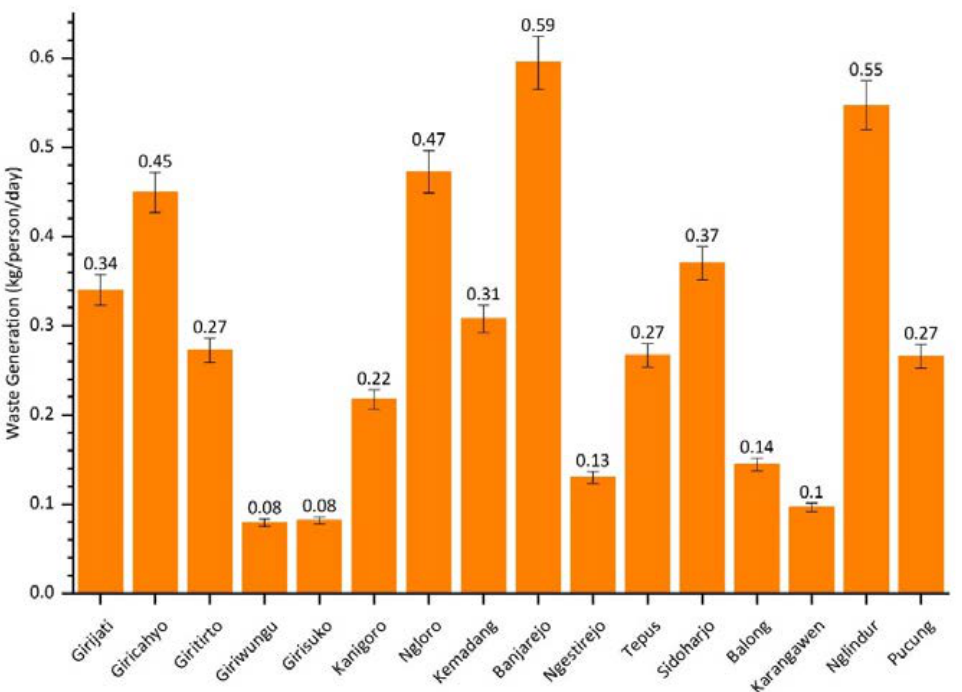
Fig. 2: Waste generation in sample villages